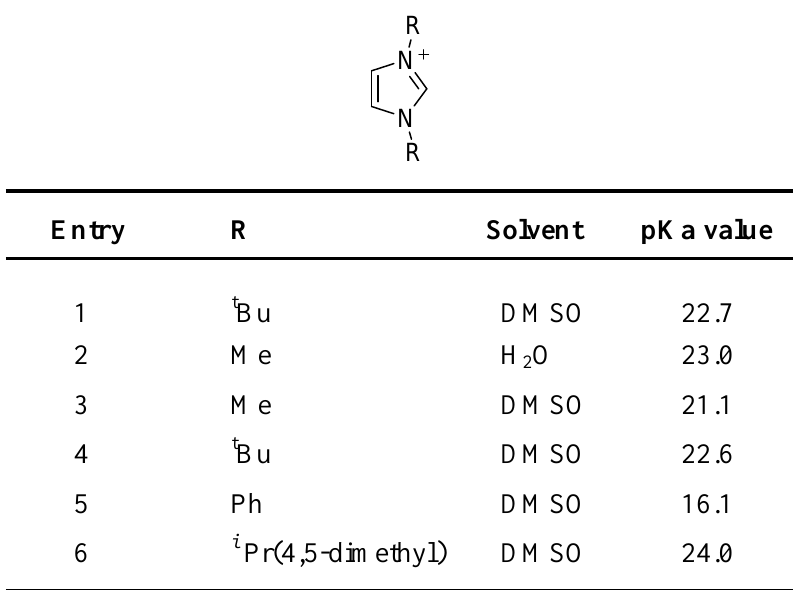
Table 2. pKa values with different substituents on imidazolium